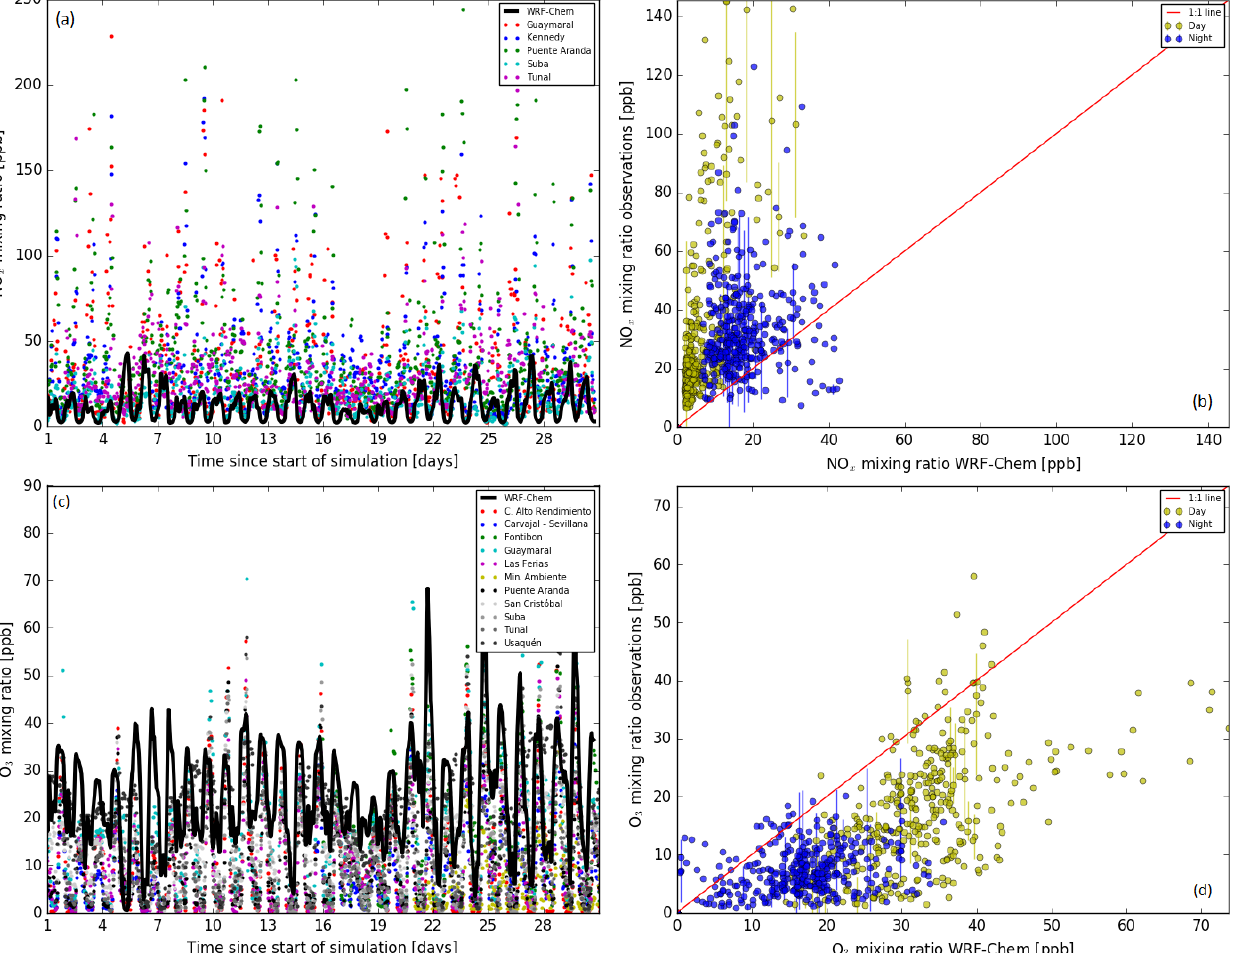
Figure 6. Temporal evolution of (a) NO x and (c) O 3 mixing ratios (ppb) in Bogotá for WRF-Chem (black solid line) and all available observational stations (colored points). Scatterplots of the WRF-Chem output compared with averaged (b) NO x and (d) O 3 mixing ratios (ppb) from the stations are split into day (yellow) and night (blue). The error bars indicate the standard deviation of the observational data from randomly sampled points (not all standard deviations are shown for visual